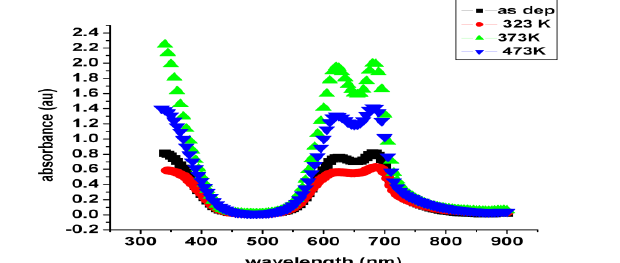
Figure 2. (Optical absorption spectra of ZnTTBPc thin film with different annealing